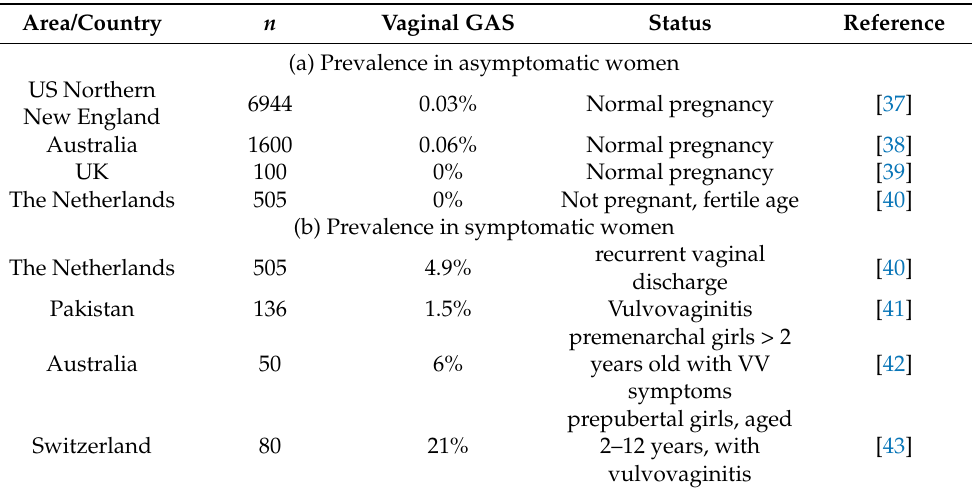
Table 4. Published prevalence of vaginal GAS colonization in asymptomatic pregnant women (panel a) and pregnant women with symptoms of vulvovaginitis (panel b).